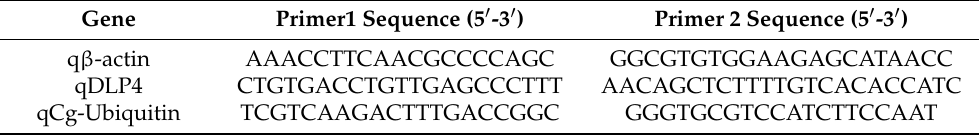
Table 1. Primer sequences for the quantitative real-time PCR. Gene Primer1 Sequence (5 (cid:48) -3 (cid:48) ) Primer 2 Sequence (5 (cid:48) -3 (cid:48)